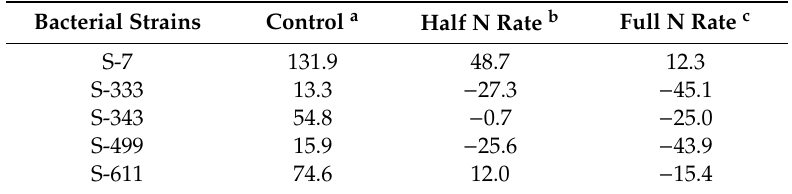
Table 6. Relative increase in N uptake (%) in upland rice inoculated with non-native PGPB. Increase in N uptake of inoculated plants relatively to the control ( a ), the half ( b ) and full ( c ) doses of chemical N fertilizer